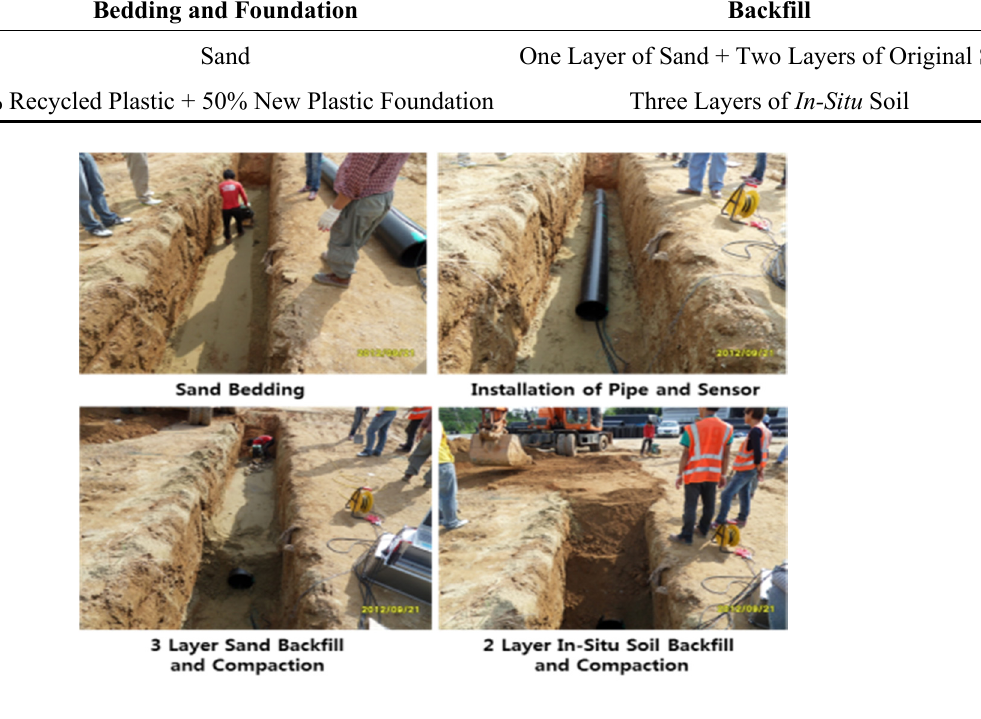
Figure 12. Field construction process.